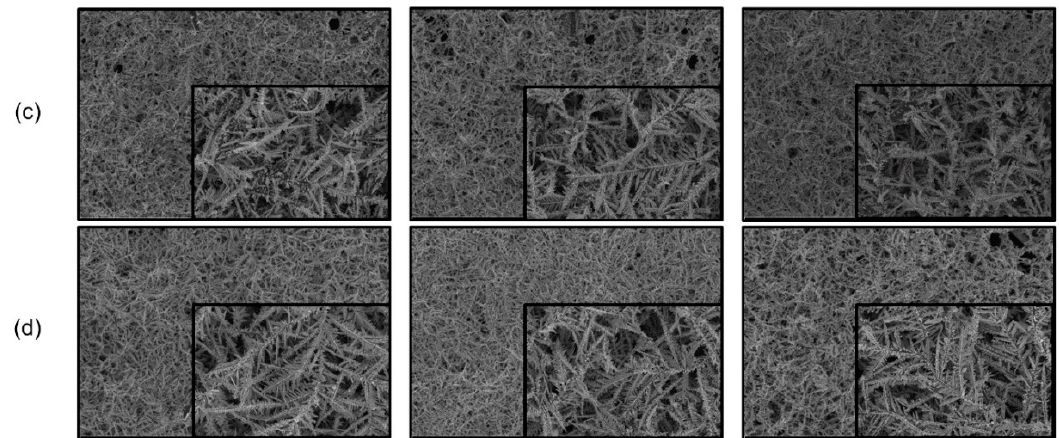
Figure 6. FE-SEM images of the fabricated 25.5 cm 2 Ag GDE (Figure 5) according to the position on the electrode. Ag deposition was performed with different working–counter electrode distances: ( a ) 1 cm, ( b ) 2 cm, ( c ) 4 cm, and ( d ) 5 cm.